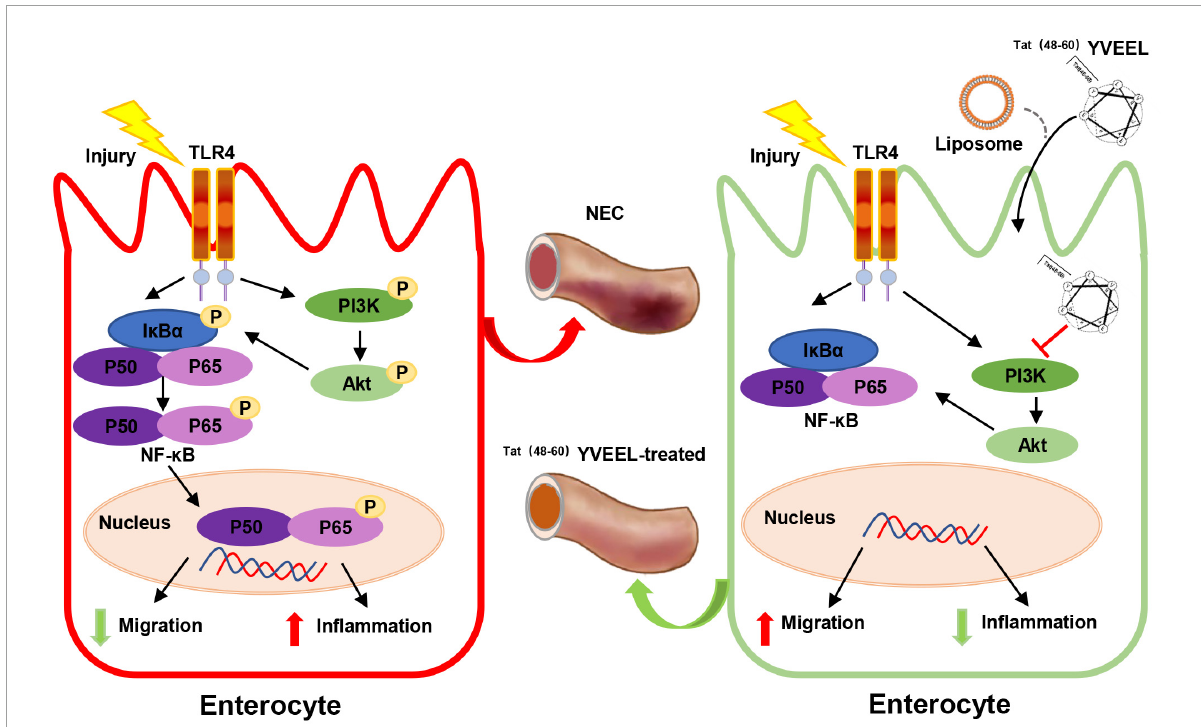
FIGURE7 Scheme of the protective effects of Tat ( 48 - 60 ) YVEEL on experimental NEC. Tat ( 48 - 60 ) YVEEL exerts a powerful effect on TLR4-mediated signaling in enterocytes which involves the inhibition of PI3K/AKT